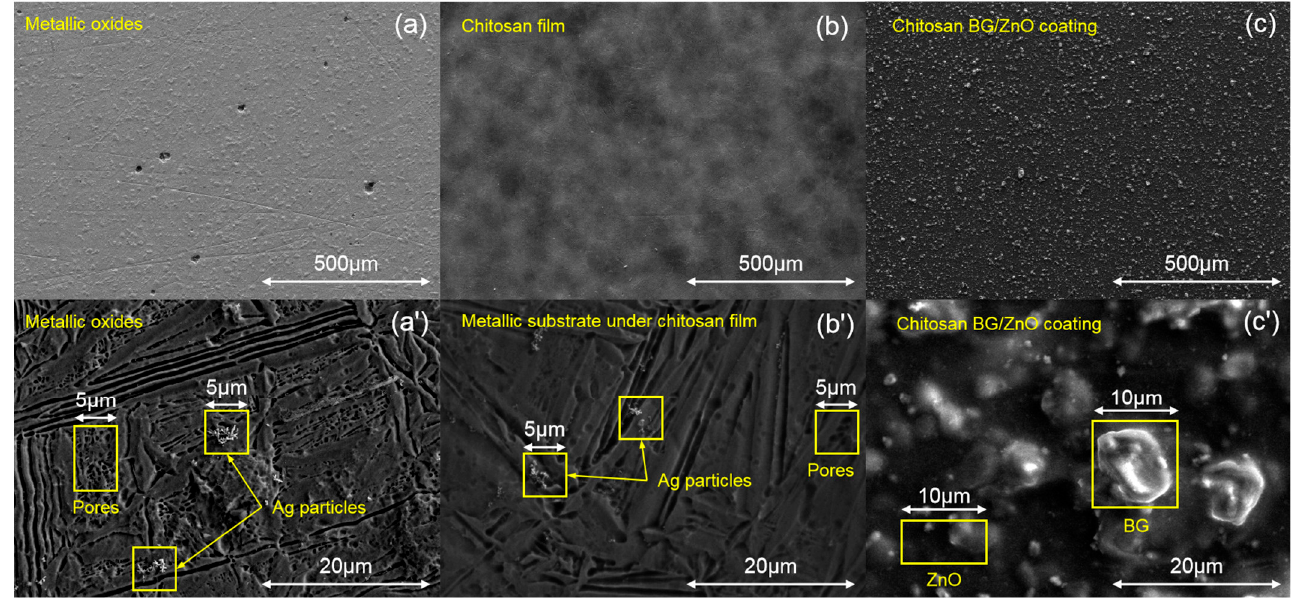
Figure 4. SEM micrographs for ( a , a’ ) P0; ( b , b’ ) P1; ( c , c’ ) P5.